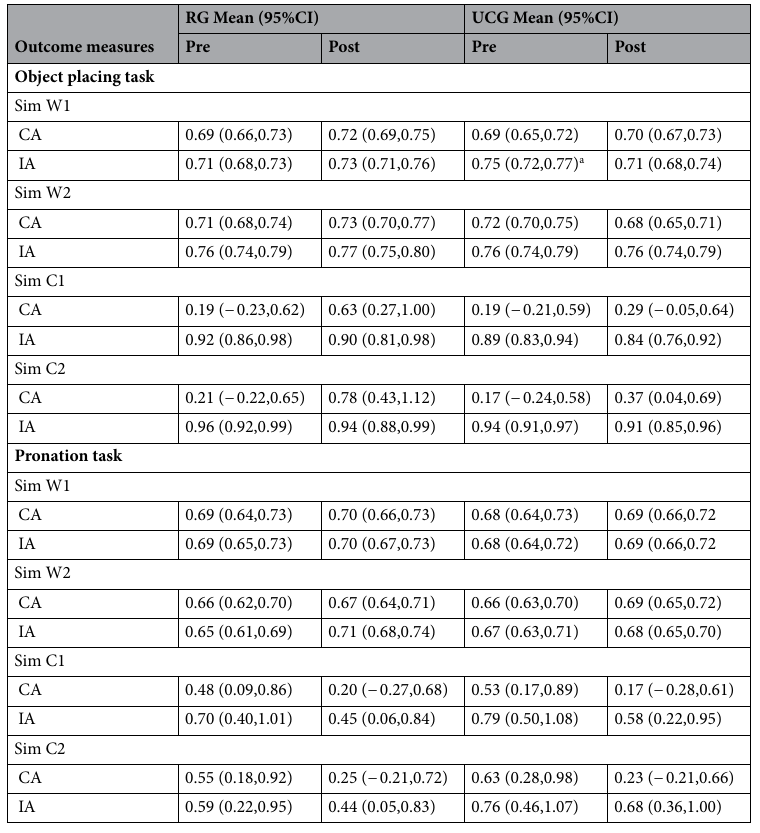
Table 4. Mean and 95% confidence interval (CI) of pre and post values of the similarity of muscle synergies for Robot group (RG) and Usual care group (UCG). Sim W1: similarity of weightings of muscle synergy 1 with respect to those of healthy subjects. Sim C1: similarity of activation profile of muscle synergy 1with respect to those of healthy subjects. Sim W2: similarity of weightings of muscle synergy 2 with respect to those of healthy subjects. Sim C2: similarity of activation profile of muscle synergy 2 with respect to those of healthy subjects. CA, Contralesional Arm; IA, Ipsilesional Arm. a Statistically significant differences with respect to RG at